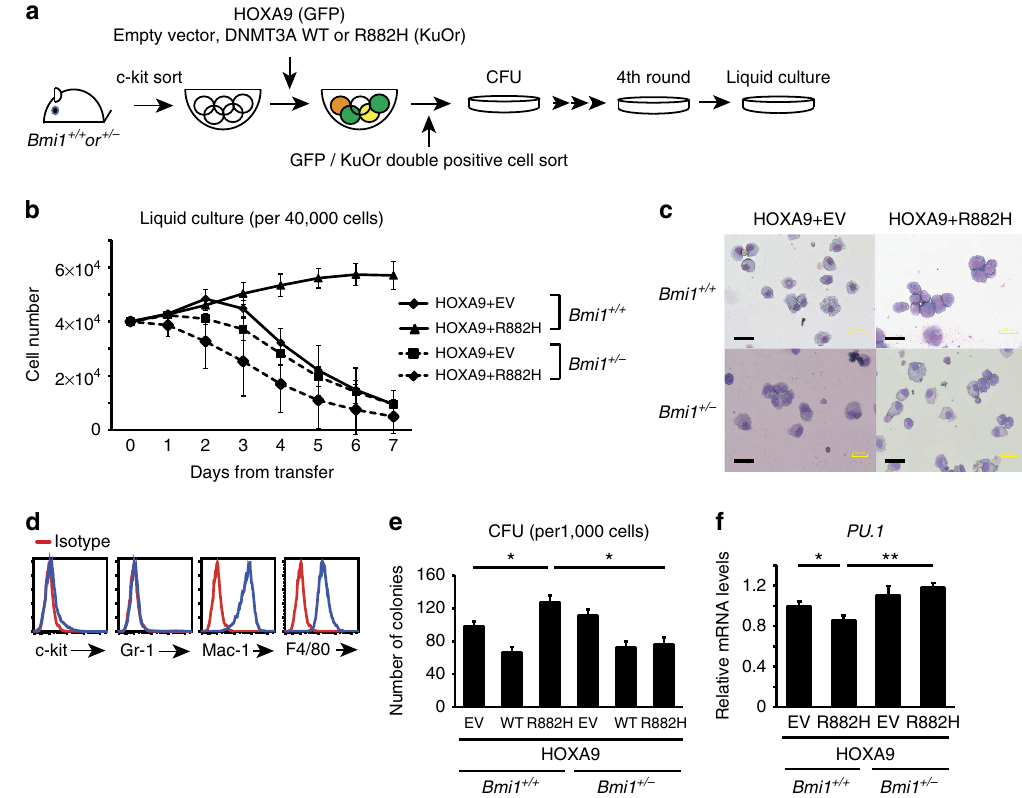
Figure 7 | PRC1 contributes to development of DNMT3A mutant-associated leukaemic cells. ( a ) Design of CFU assay and liquid culture assay with HOXA9 and EV-, WT- or R882H-transduced c-kit þ Bmi1 þ / þ or Bmi1 þ / (cid:2) murine BM cells. ( b ) Growth curve of Bmi1 þ / þ and Bmi1 þ / (cid:2) murine immortalized cells transduced with HOXA9 and EV or R882H in liquid culture; N ¼ 3 replicate experiments. ( c ) Typical morphology of Bmi1 þ / þ and Bmi1 þ / (cid:2) murine immortalized cells transduced with HOXA9 and EV or R882H in liquid culture. Scale bar, 20 m m. ( d ) Representative surface-marker profile of Bmi1 þ / þ murine immortalized cells transduced with HOXA9 and R882H. ( e ) Cumulative colony-forming capacity is shown for an initial plating of 1,000 co-transgene-expressing cells; N ¼ 3 replicate plates. P values were calculated using two-tailed unpaired t -test. ( f ) Relative expression levels of PU.1 in co-transduced cells at first round measured by qPCR; N ¼ 3 replicate experiments, normalized to the expression levels in HOXA9 and EV co-transduced cells. P values were calculated using two-tailed unpaired t -test. BM, bone marrow; CFU, colony-forming unit; EV, empty vector; PRC1, polycomb repressive complex1; qPCR, quantitative polymerase chain reaction; WT, wild type. Data are mean ± s.d. values. * P o 0.05, ** P o